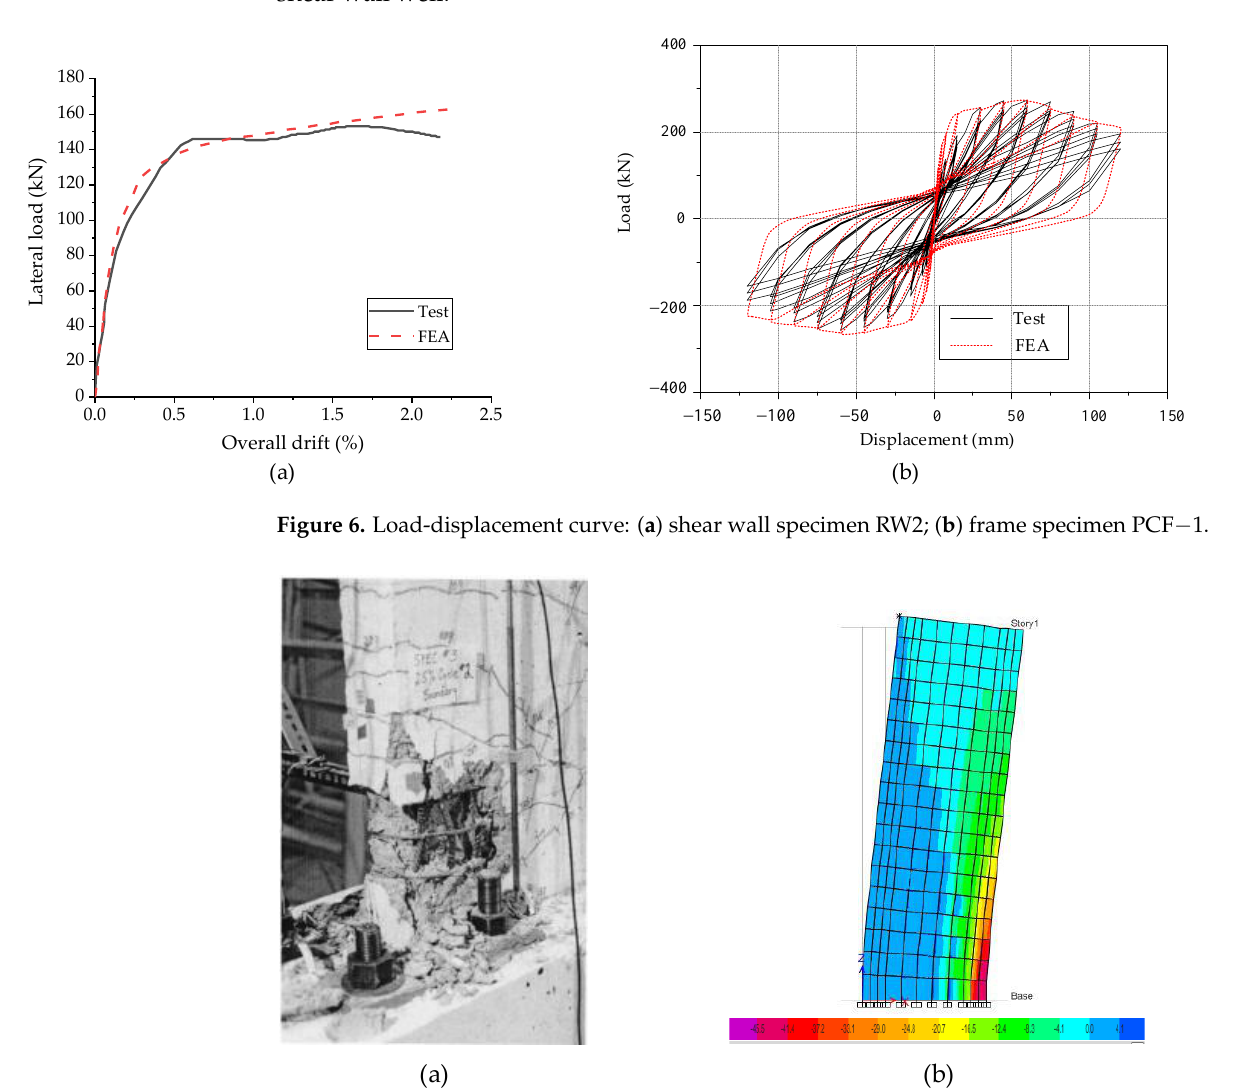
Figure 7. Failure mode of specimen RW2: ( a ) test; ( b ) FEA.